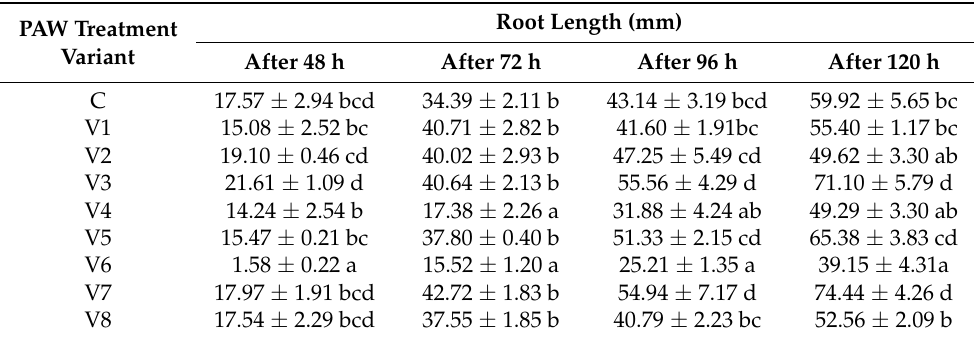
Table 5. Dynamics of embryonic root length growth in wheat under the influence of non-thermal plasma-activated water